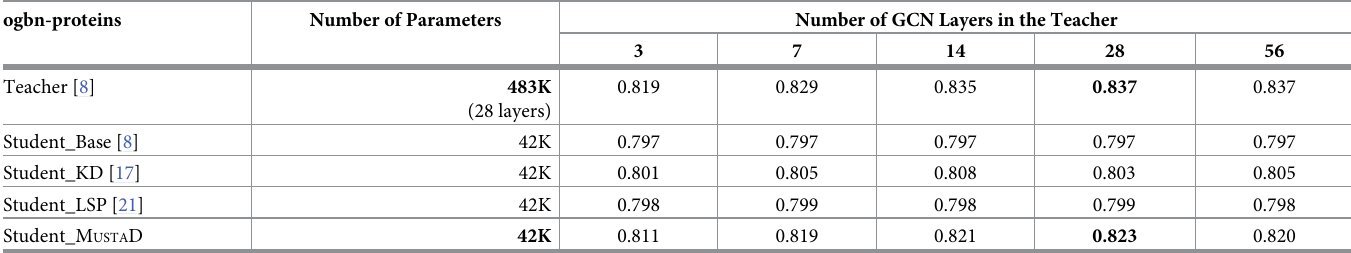
Table 4. Multi-labeled node classification performance (AUC-ROC) in ogbn-protein. The distillations are done from trained teachers with different numbers of GCN layers: 3, 7, 14, 28, and 56. Note that the proposed method Student_M USTA D provides the best performance among the student models.